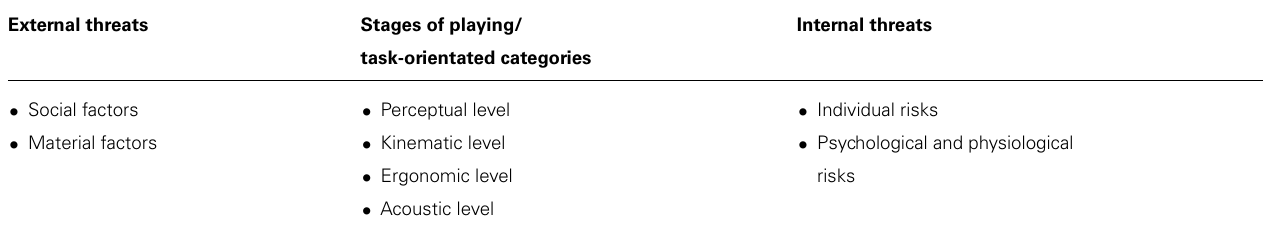
Table 2 |A conceptual risk-management framework for